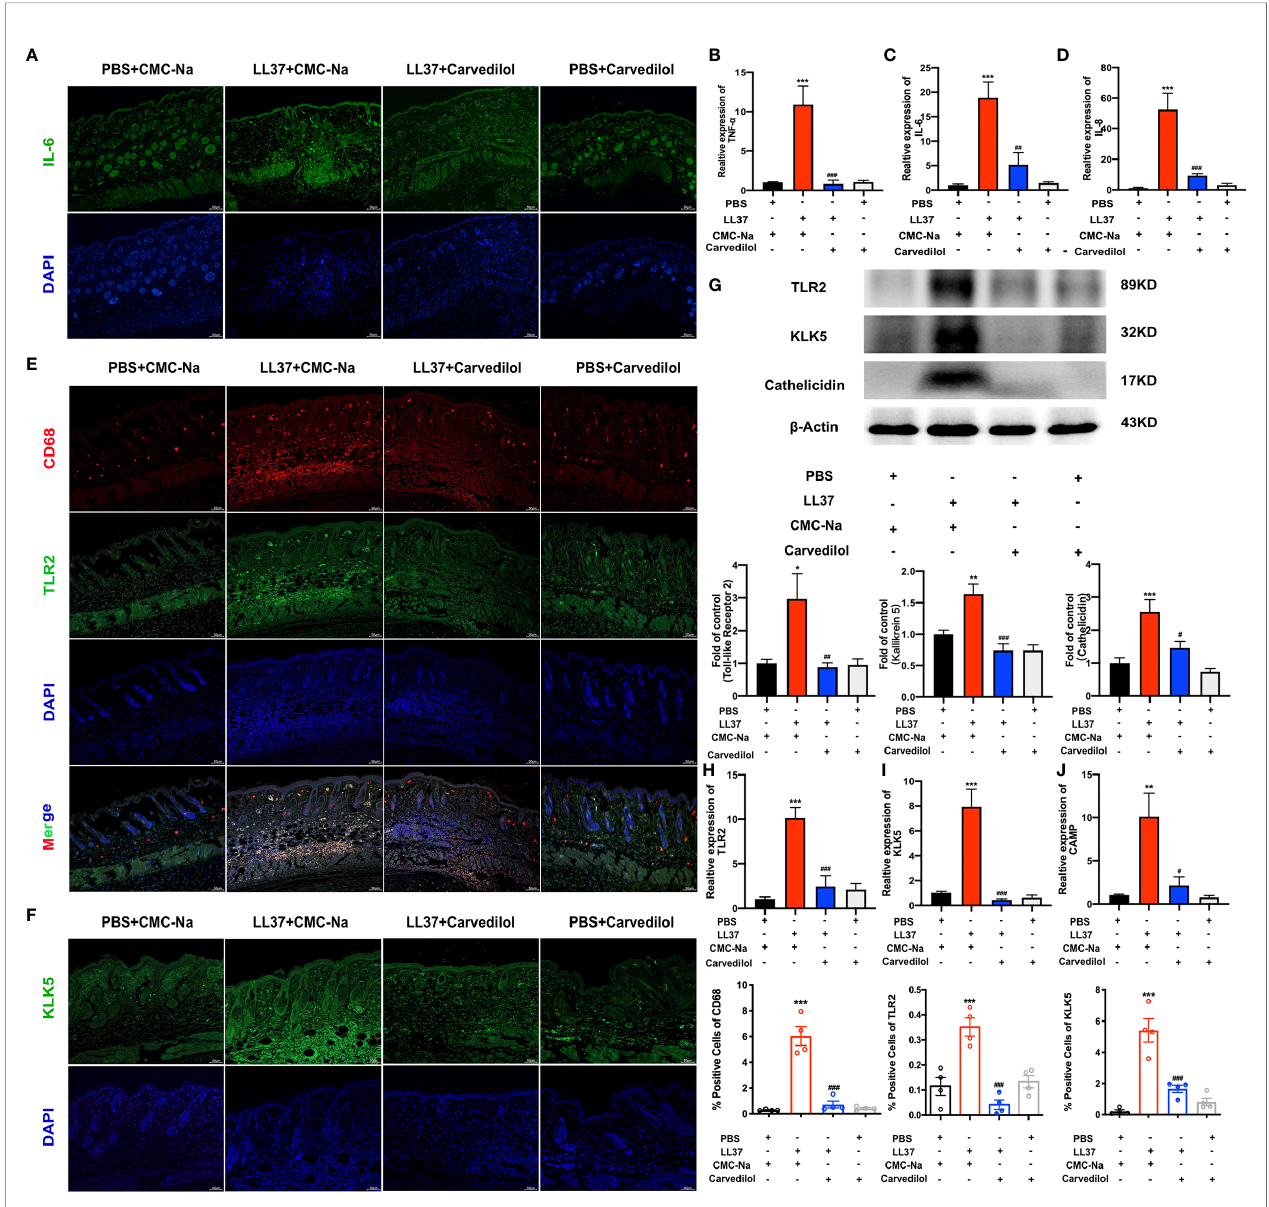
FIGURE 3 | Carvedilol inhibits the expression of TLR2, KLK5, and cathelicidin and in fl ammatory factors in a mouse model of rosacea-like dermatitis. Immuno fl uorescence staining of IL-6 showed that in fl ammatory in fi ltration increase in ll-37+CMC-Na group, and decreased in carvedilol+LL-37 group (n=4). (A) Statistical analysis of the results of RT-qPCR of the genes for TNF- a , IL-6 and IL-8 (n=4). (B – D) Immuno fl uorescence staining of CD68 and TLR2 (n = 4). Carvedilol inhibits the expression of TLR2, KLK5, and cathelicidin in a mouse model of rosacea-like dermatitis. The expression of TLR2 and KLK5 was assessed by immuno fl uorescence, western blot, and RT-qPCR. The result shows that CD68 and TLR2 increased in the LL-37+CMC-Na group and decreased in the LL-37 +carvedilol group, implying that the LL-37+CMC-Na group expressed more macrophages and TLR and that these could be down-regulated by carvedilol. Conversely, PBS or carvedilol alone did not cause obvious changes. (E) Immuno fl uorescence staining of KLK5 (n = 4). (F) The expression of KLK5 in the four groups was consistent with the results from (E) . Western blot analysis and quantitative results of TLR2, KLK5, and cathelicidin (n = 7). (G) Statistical analysis results of RT- qPCR of the genes for TLR2, KLK5, and cathelicidin (n = 4). (H – J) The expression of TLR2, KLK5, and cathelicidin protein and mRNA in the four groups also revealed similar trends as observed in (E, F) . *P < 0.05, **P < 0.01, ***P < 0.001, # P < 0.05, ## P < 0.01, ### P <